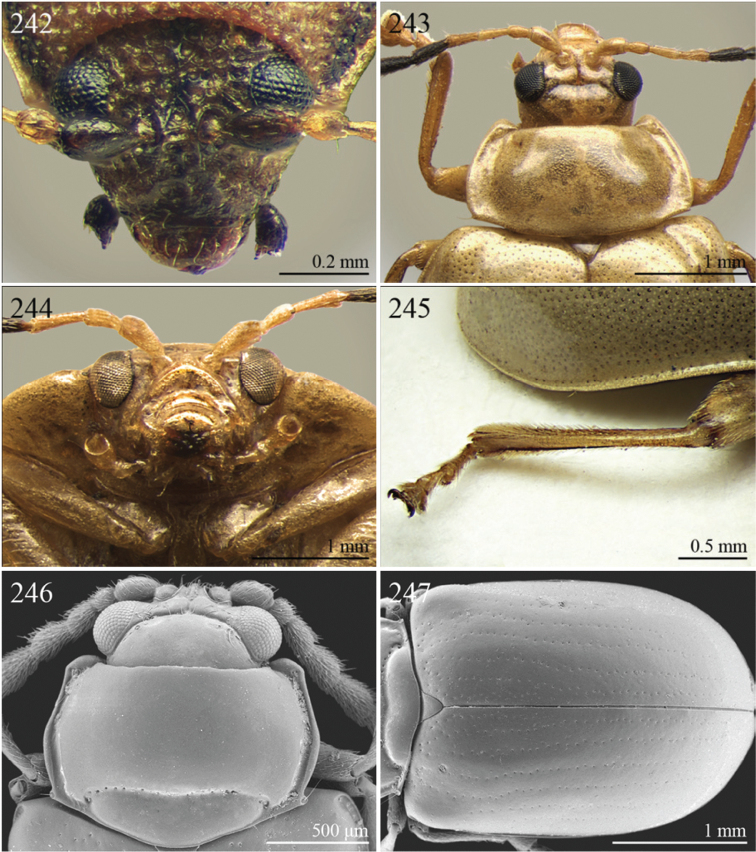
Morphological characters 242
Pratima vinsoni Bechyné, head in frontal view 243 Pseudadorium balyanum (Csiki), head and pronotum in dorsal view 244 Ditto, head in frontal view 245 Ditto, hind leg in sublateral view 246
Pseudophygasia analis (Harold), head and pronotum in dorsal view 247 Ditto, elytral punctation.